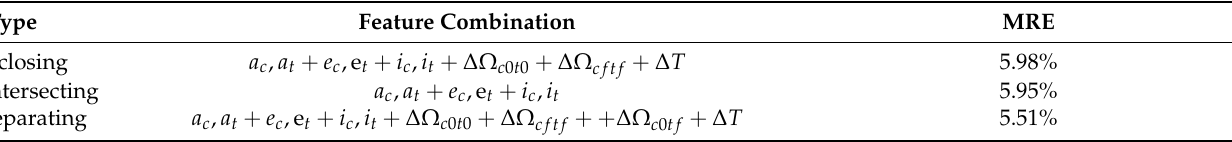
Table 4. Selected learning features for the three types of perturbed multiple-impulse